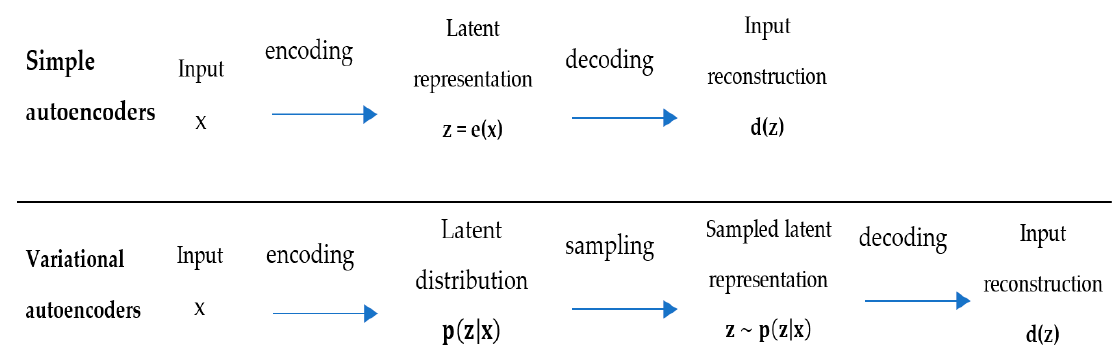
Figure 7. Difference between autoencoders and variational autoencoders [50].